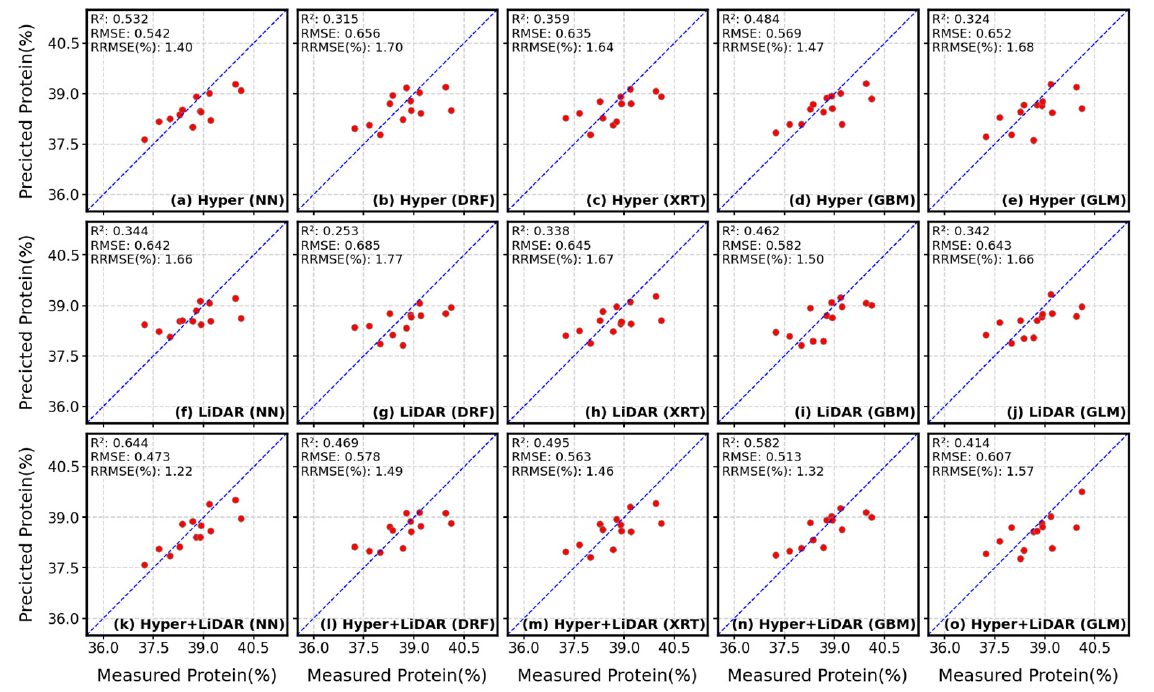
Figure 7. Scatter plots of the measured vs. predicted soybean protein concentration using different models with hyper-based, LiDAR-based and Hyper + LiDAR-based features, respectively.